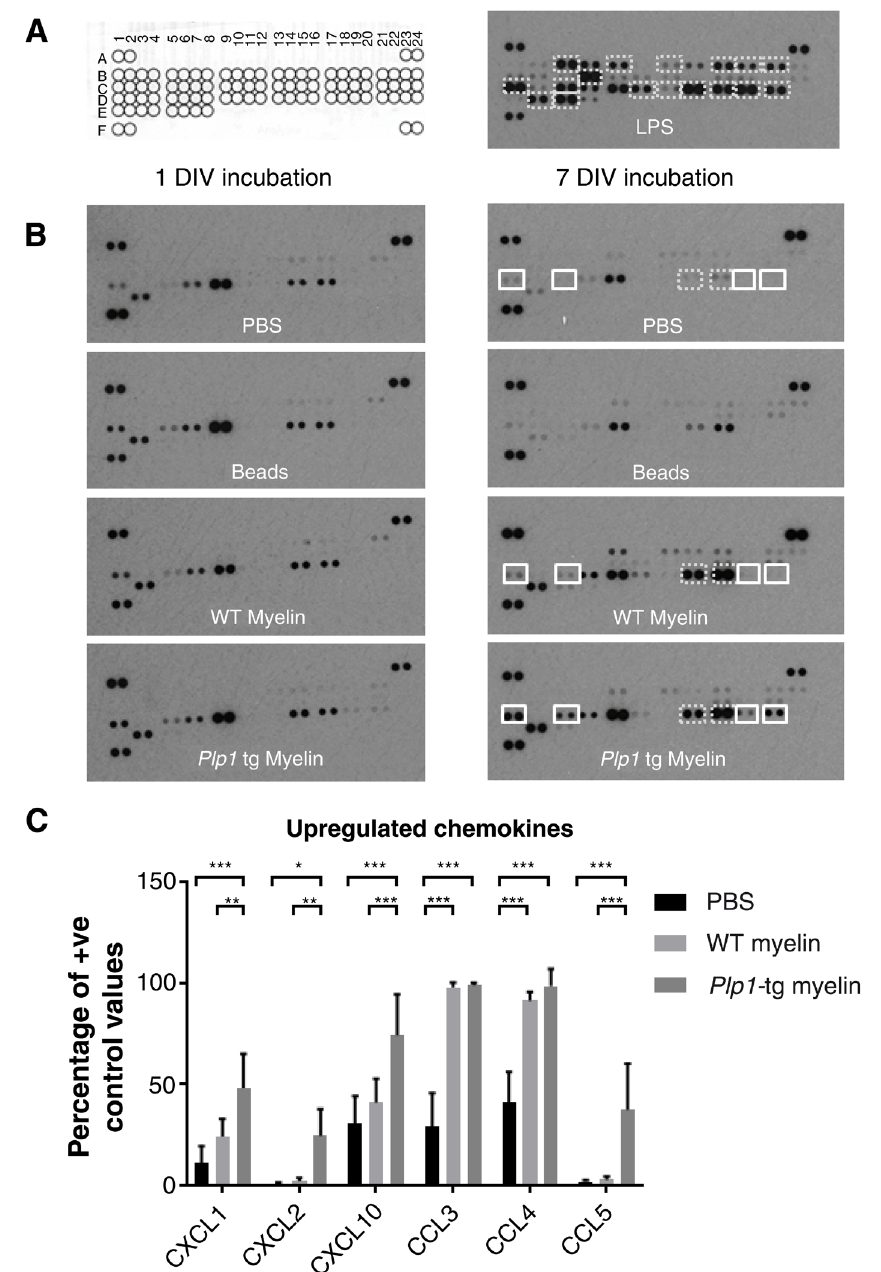
Figure 4. Spinal cord cultures mount appropriate responses to diverse stimuli. A . Map of proteome arrays shows six positive control (A1,2; A23,24; F1,2) and two negative control (F23,24) spots, alongside 40 paired cytokine-specific spots (B1,2-E7,8). The array on the right was incubated with medium from cultures treated with LPS. A number of cytokines and chemokines (highlighted with white boxes), including pro-inflammatory cytokines, were upregulated in LPS-treated cultures compared to PBS-treated controls. Quantification is provided in the text. B . Proteome arrays incubated with medium from cultures treated with a myelin-enriched tissue fraction from wild type or a spontaneously demyelinating model of Pelizaeus Merzbacher disease ( Plp1 tg myelin) for 1 or 7 days. After 7 days, two chemokines were upregulated in cultures treated with wild type or Plp1 tg myelin compared to PBS-treated cultures (highlighted with boxes with broken lines). An additional four chemokines were upregulated specifically in Plp1 tg myelin-treated cultures compared to wild type myelin-treated cultures (highlighted with boxes with solid lines). C . Graph of chemokines upregulated in cultures treated with myelin-enriched tissue preparations for 7 days. Bars represent mean +/- s.e.m. n = 3 independent cultures to which 6 independent myelin preparations were added (1 preparation per independent experiment from wild type mice and 1 preparation per independent experiment from Plp1 transgenic mice). Each cell culture (considered n = 1 independent biological repeat) comprises up to 24 × 35 mm dishes each containing 3 coverslips coated with cells. Eight 35 mm dishes are contained within one 25 mm diameter dish. Wild type or Plp1 transgenic myelin were added to two 35 mm dishes, from within one larger 25 mm diameter dish. There was no systematic selection process for deciding which dishes would receive wild type versus Plp1 transgenic myelin, as all dishes were identical. Raw data files attached. * p < 0.05, ** p < 0.01, *** p <